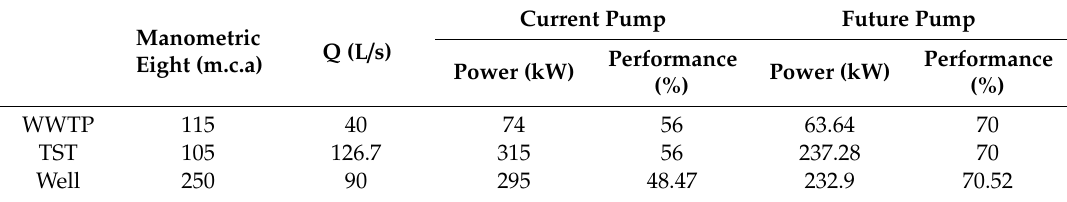
Table 2. Details of the elevation pumps and adopted improvements.